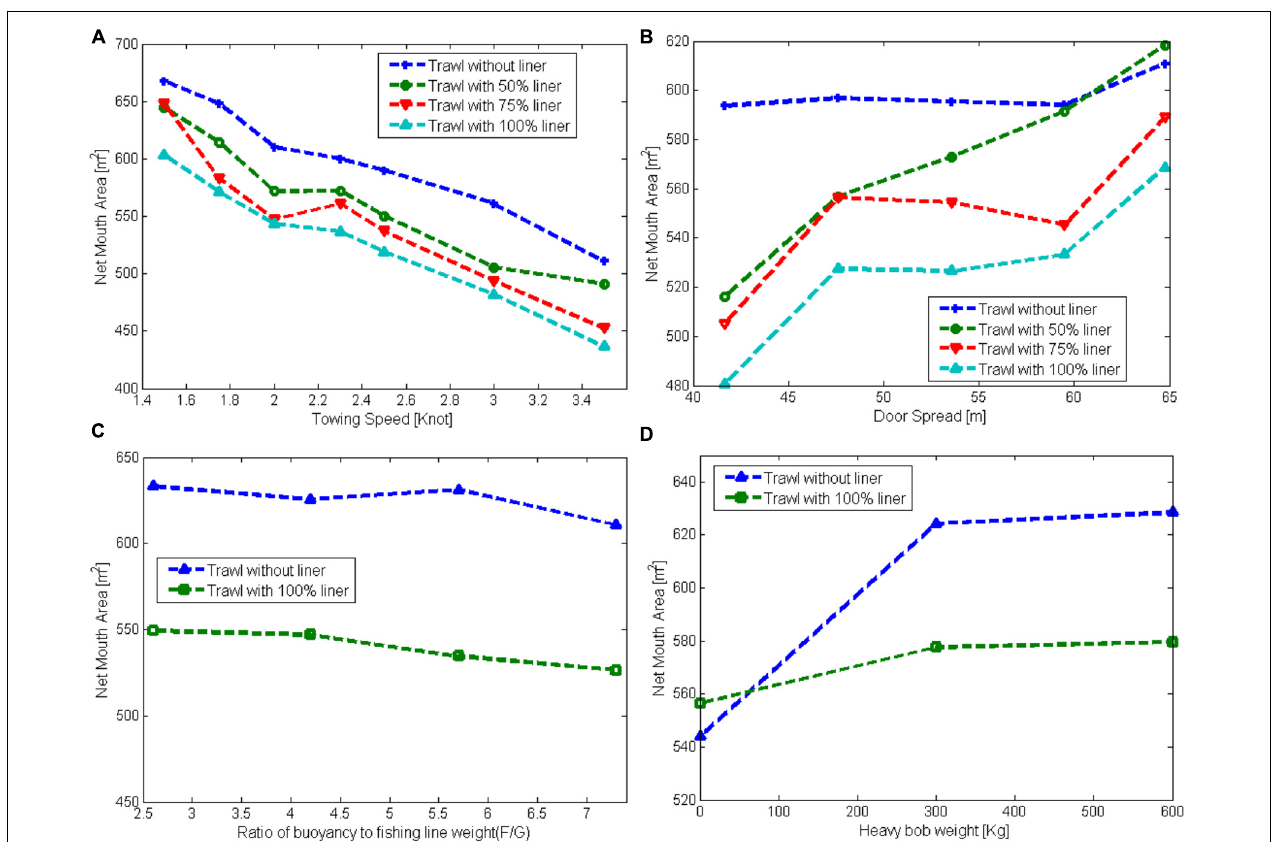
FIGURE 10 | The mouth net area of different trawls about the (A) towing speed, (B) door spread, (C) ratio of buoyancy to F / G , and (D) heavy bob weight: current data estimated with 95% confidence intervals from the statistical